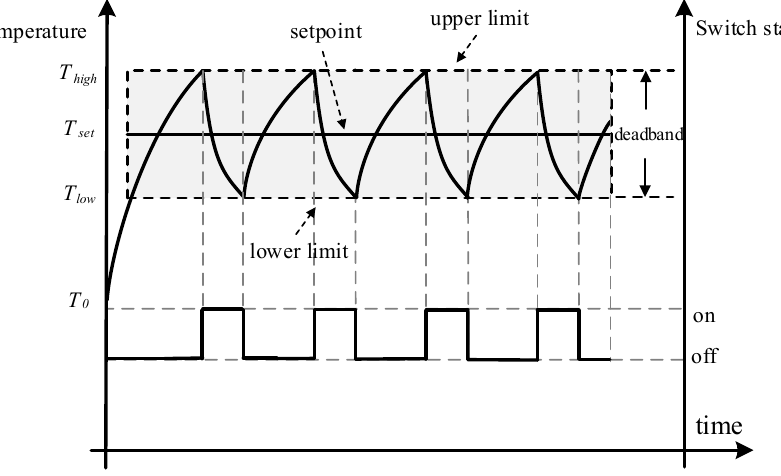
Figure 4. Indoor Temperature Curve of Uncontrolled Terminal User.